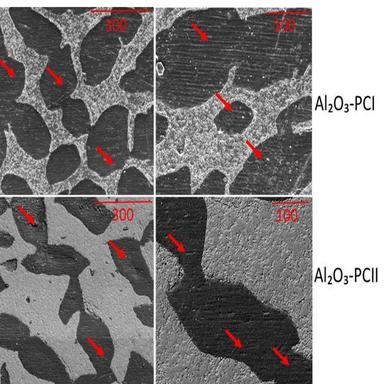
SEM images illustrating the effect of simulated toothbrushing on the Al2O3-PC interpenetrating phase composites. The darker areas represent the polymer and the lighter areas represent the alumina. The red arrows indicate the effect of the brushing (polymer part of the composites). (For interpretation of the references to color in this figure legend, the reader is referred to the web version of this article.)